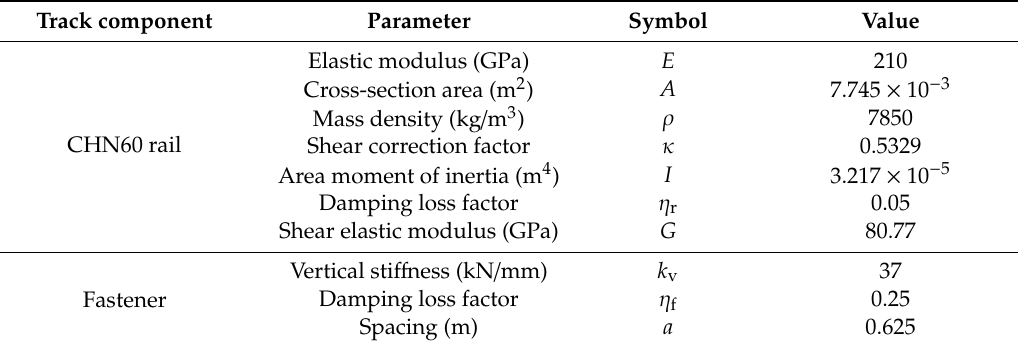
Table 1. Parameters of